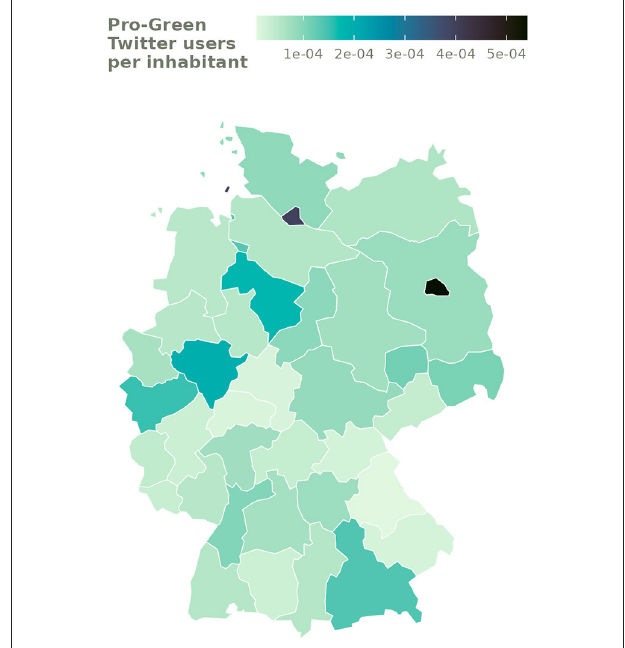
FIGURE 4 | Number of users who tweeted in support for the Green party during the 30-day period leading up to the 2021 German federal election divided by population per NUTS-2